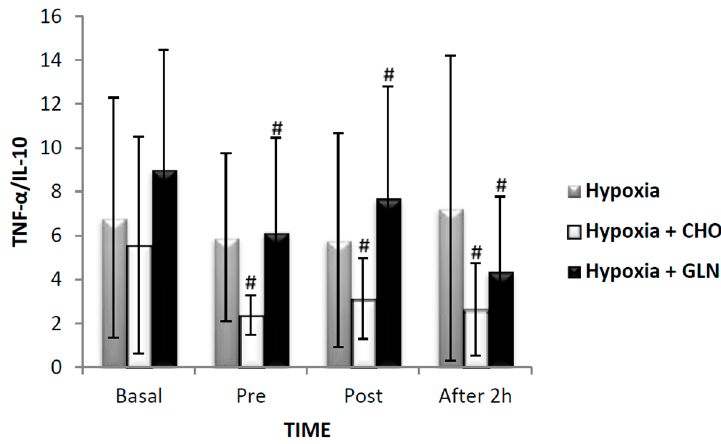
Figure 7. The results of salivary secretion rate of Tumor necrosis factor- α /Interleukin-10 (TNF- α /IL-10) was described by mean ± Standard Error (SE). The interaction of group versus time was analyzed by Analysis of Variance (ANOVA) for repeated measures followed by post hoc of Tukey test. The level of significance was set at p < 0.05. n = 15 volunteers. # Different in relation to Basal. Hypoxia + CHO = Hypoxia + carbohydrate and hypoxia + GLN = hypoxia + glutamine.